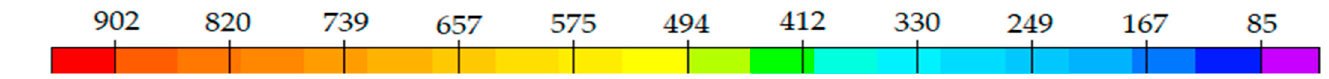
Figure 10. Temperature scale for standard fire mode.